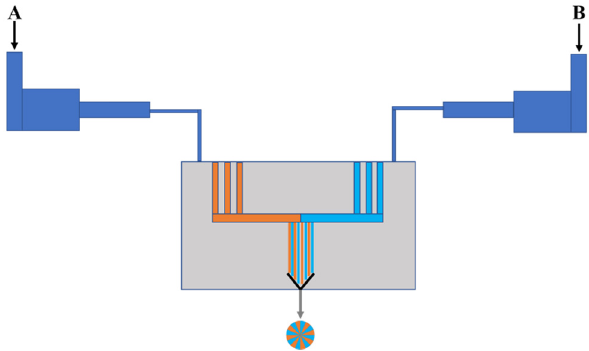
Figure 4: Schematic diagram of the preparation of segmented - pie fi bers by the melt - spinning